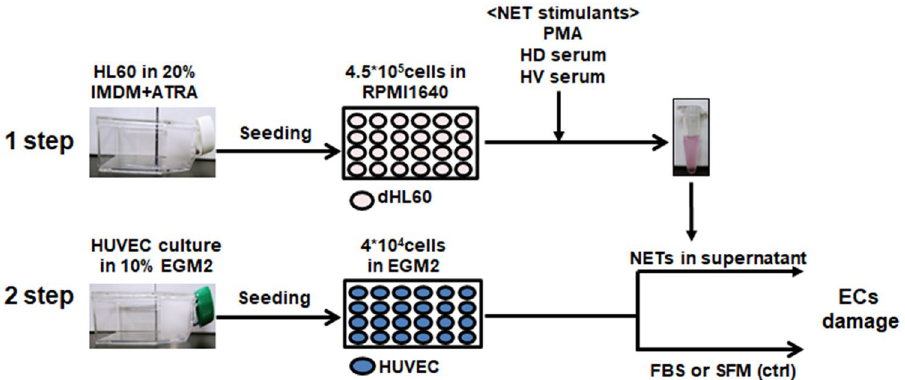
Figure 5. Schematic diagram of the experimental procedure. HL-60 cells were seeded into T75 flasks at 5 × 10 5 cells/mL and cultured for 6 days in 20% IMDM with 1 nM ATRA. Differentiated HL-60 cells were seeded into 24-well plates at 4.5 × 10 5 per well and cultured in RPMI1640 with 1% BSA. PMA, HV serum and HD serum were applied to dHL-60 cells for 17 h and nuclease was added for 1 h. Cell free–NETs in supernatants were transferred to a new e-tube containing EDTA. HUVEC cells were cultured in 10% EGM2 and 4 × 10 4 were seeded into 24-well plates. The day before the experiment, the culture medium was replaced with serum-free medium (SFM), 10% FBS, or 10–20% of NET supernatant. Cells were incubated for 20 h and used for